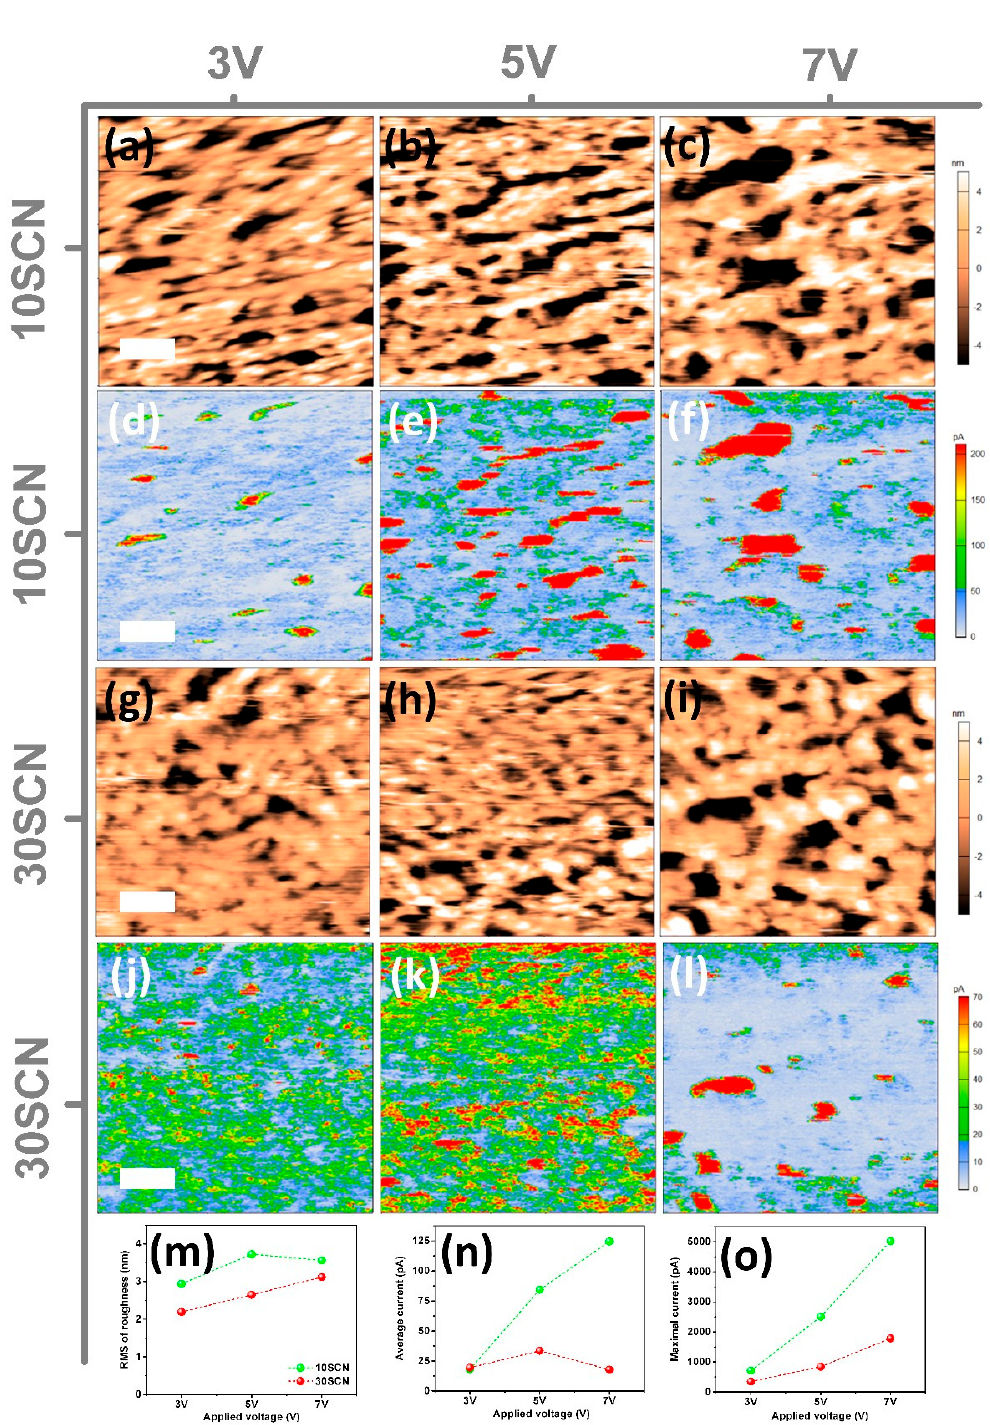
Figure 3. ( a – c ) Topography and ( d – f ) current mapping images of 10SCN NC film under 3 V, 5 V and 7 V; ( g – i ) topography and ( j – l ) current mapping images of 30SCN NC film under 3 V, 5 V and 7 V; comparison of ( m ) roughness, ( n ) average current, and ( o ) maximum current of 10SCN and 30SCN NC films under voltages. The scale bars are 200